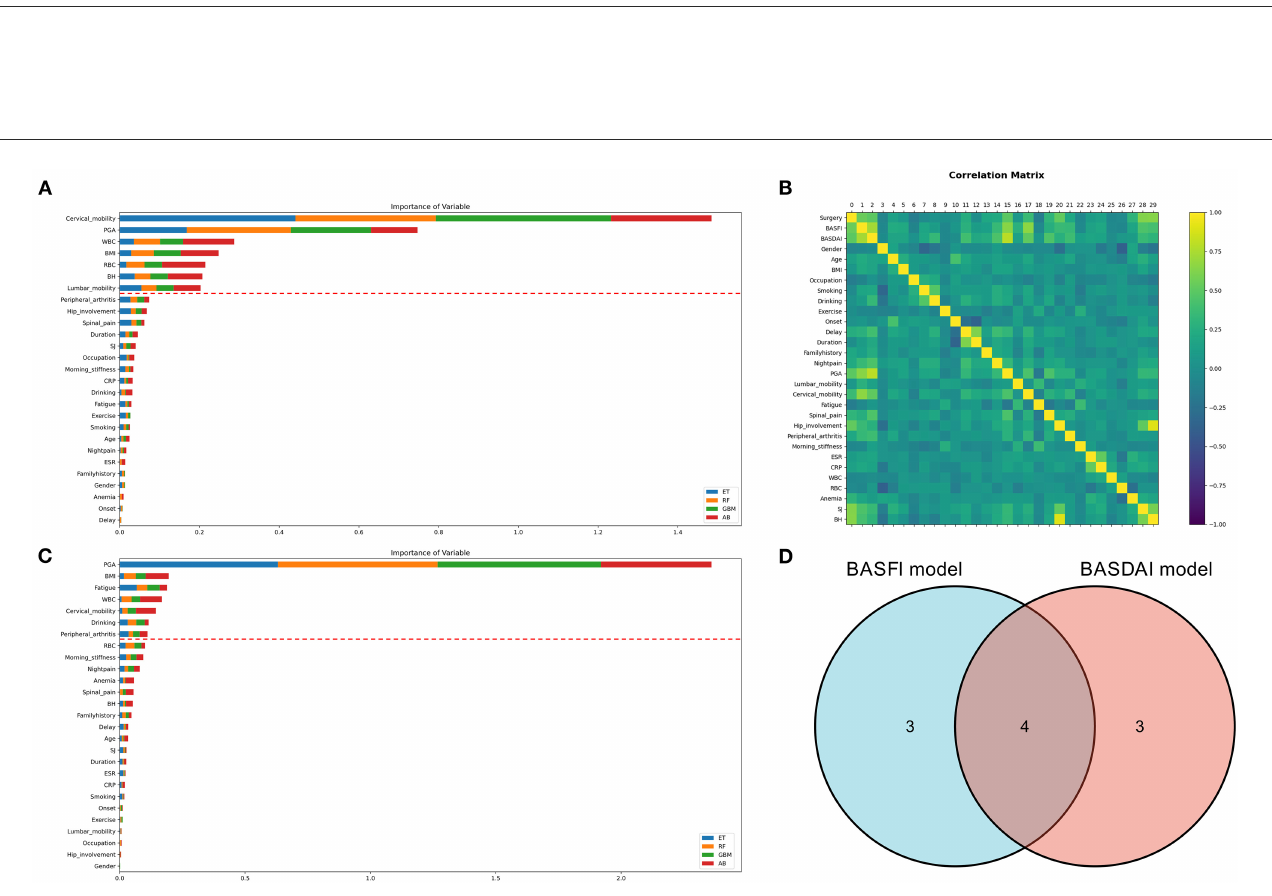
FIGURE4 Variable selection for clinical prediction models. (A, C) The variable importance ranking for constructing the BASFI prediction model and BASDAI prediction model, respectively. (B) Correlation heat map of the variables in the training set. (D) Venn diagrams for the above two models incorporating variables (ET, Extra Tree Regressor; RF, Random Forest Regressor; GBM, Gradient Boosting Machine Regressor; AB, AdaBoost